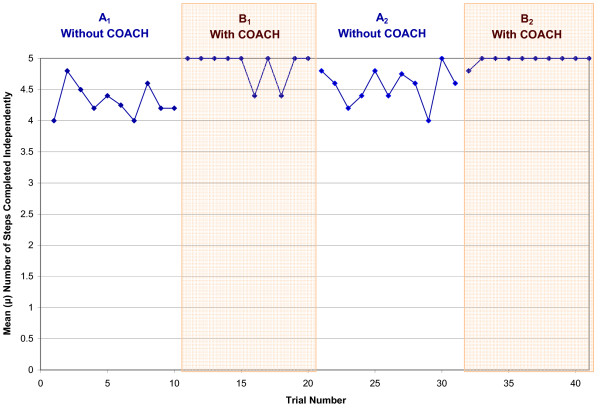
Mean number of steps completed independently for all participants for each day of the trials. A1 and A2are the baseline phases (no use of COACH), B1and B2 are the intervention phases (COACH used).